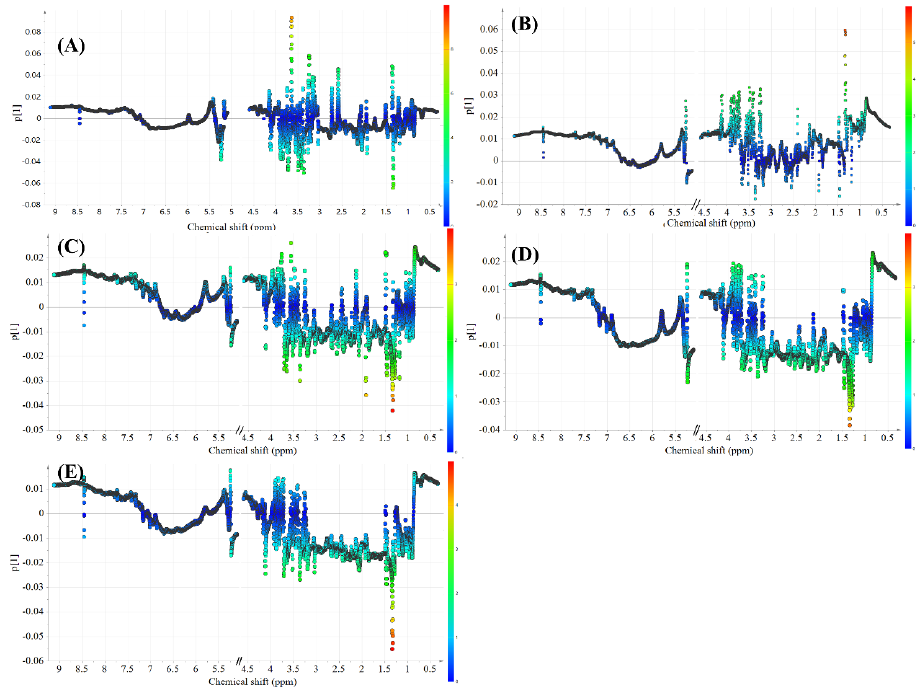
Figure 7. Loading plots of OPLS-DA models: ( A ) model group vs. normal group, ( B ) model group vs. polysaccharide knockout component of crude AB, ( C ) model group vs. polysaccharide knockout component of salt-processed AB, ( D ) model group vs. polysaccharide component of crude AB, ( E ) model group vs. polysaccharide component of salt-processed AB. The S-plots were generated to identify the significant varied endogenous metabolites with a variable importance in the projection (VIP) of more than 1.0 in the NMR data, and the results are shown in Figure 8A – D. To analyze these differential metabolites globally, the varied endogenous metabolites are listed in Table 4. Compared with the normal group, 18 differential metabolites (VIP > 1.0) were observed in the model group. Com- pared with the model group, 13 and 19 differential metabolites (VIP > 1.0) were observed in the polysaccharide knockout component of crude and salt-processed AB-treated group, respectively. Meanwhile, 21 and 22 differential metabolites (VIP > 1.0) were identified when comparing metabolites between the polysaccharide component of crude and salt- processed AB treated group and model group.